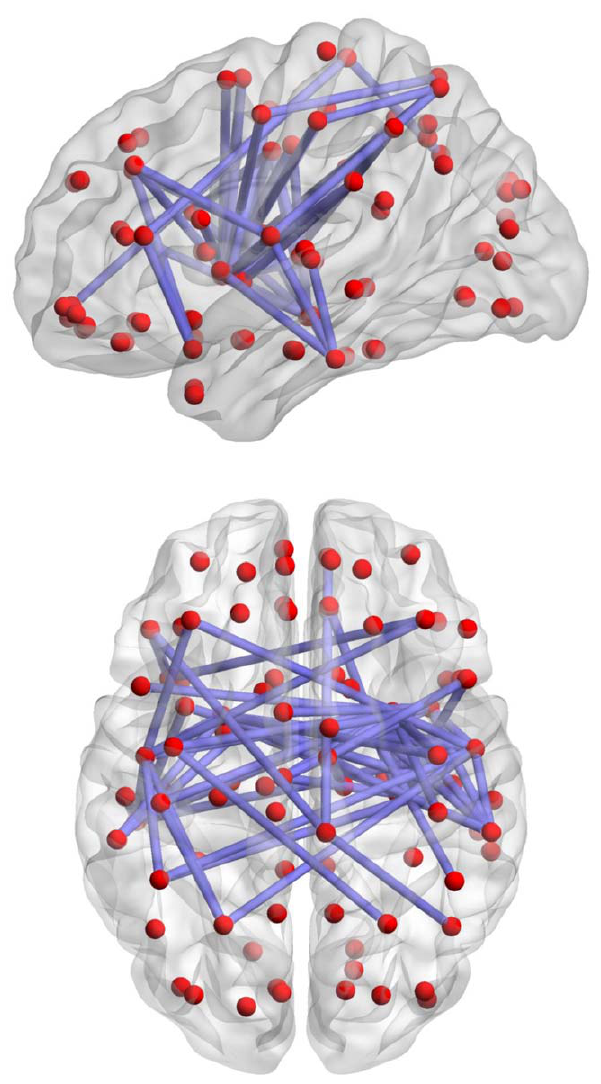
Figure 1. Network of decreased brain functional connectivity in adolescents with internet addiction. Red dots represent stereotac- tic centroids of brain regions (nodes) defined by Automated Anatomical Labeling (AAL) atlas, and blue lines represent suprathreshold links (t=3.0) comprising the affected network identified with the network- based statistic (NBS) ( p , 0.05, component-wise corrected).The axial view illustrates the involvement of interhemispheric connections (i.e., connections crossing between the right and left hemisphere). The sagittal view illustrates the involvement of frontal, temporal, and parietal lobes in the affected network.